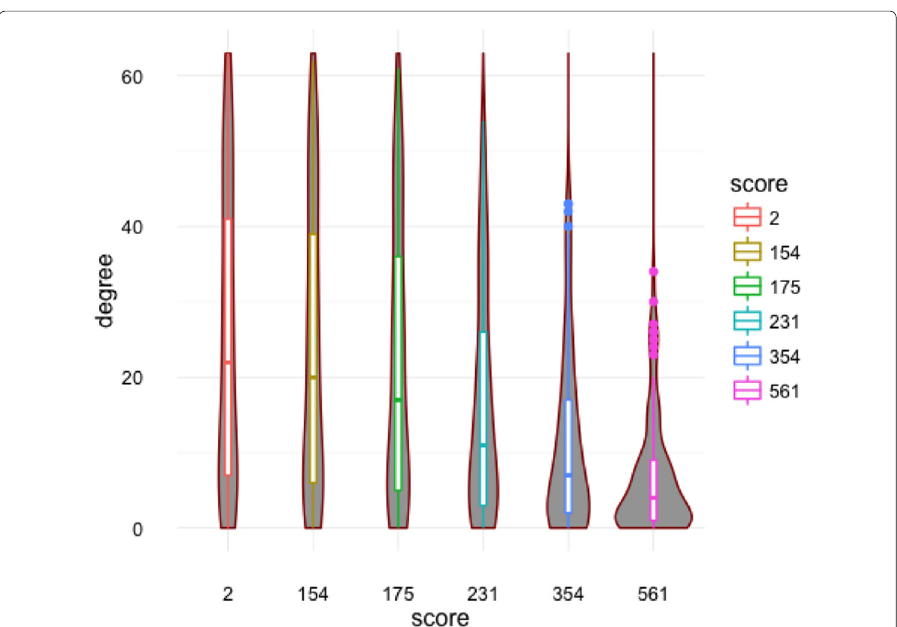
Fig. 17 Degree distribution of the private metabolites networks according to the chosen percentile